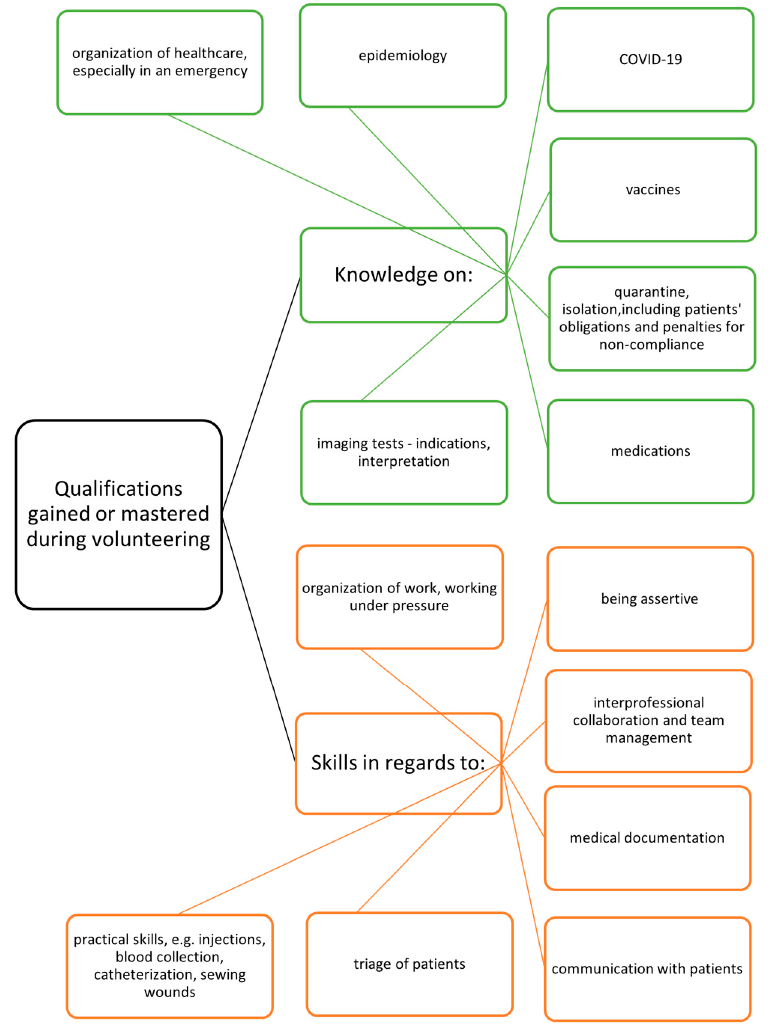
Figure 2. Knowledge and skills acquired or mastered by students during volunteering as reported by students. Table 2. Student volunteering in terms of qualifications, professional identity, and interprofessional relations.